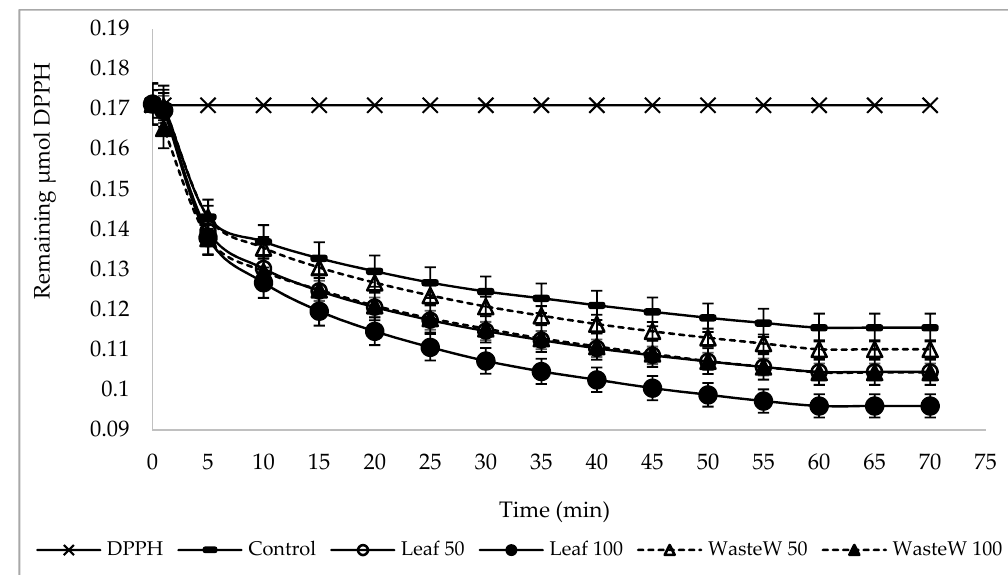
Figure 1. Time evolution of the DPPH curves in methanol of organic extracts from GF control and fortified breadsticks.